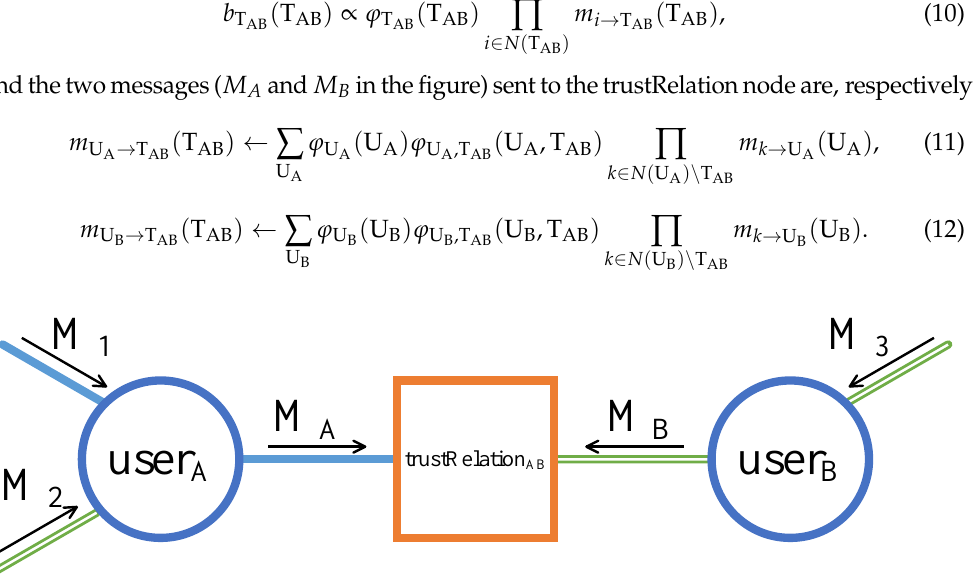
Figure 5. An illustration of passing messages through a trustor node U A and a trustee node U B to a trustRelation node T AB